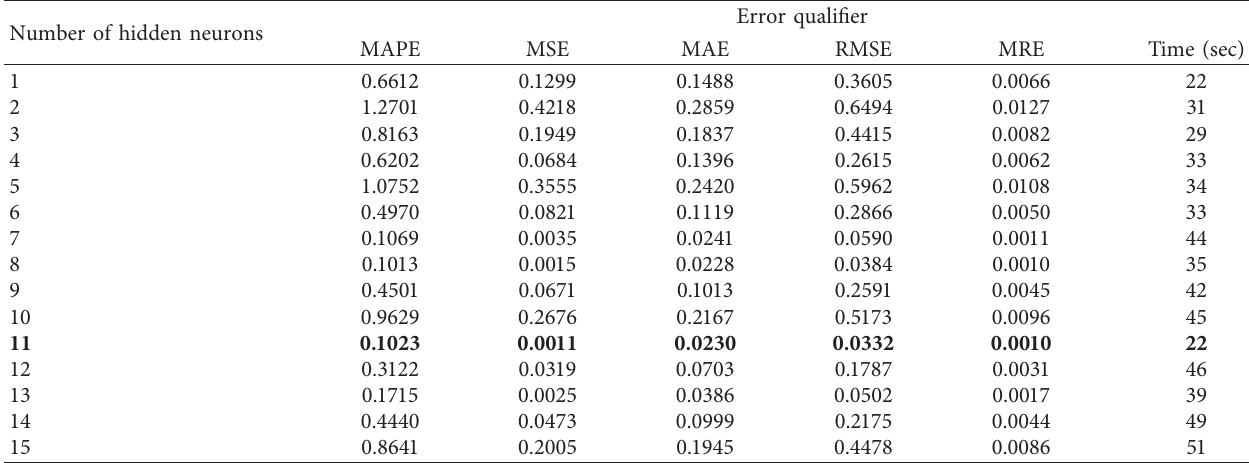
Table 6: The proposed five input-based Elman neural network statistical performance analyses with various hidden neurons for temperature forecasting. Number of hidden